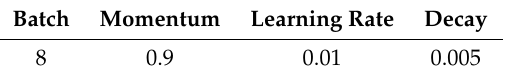
Table 2. Initialization parameters used in